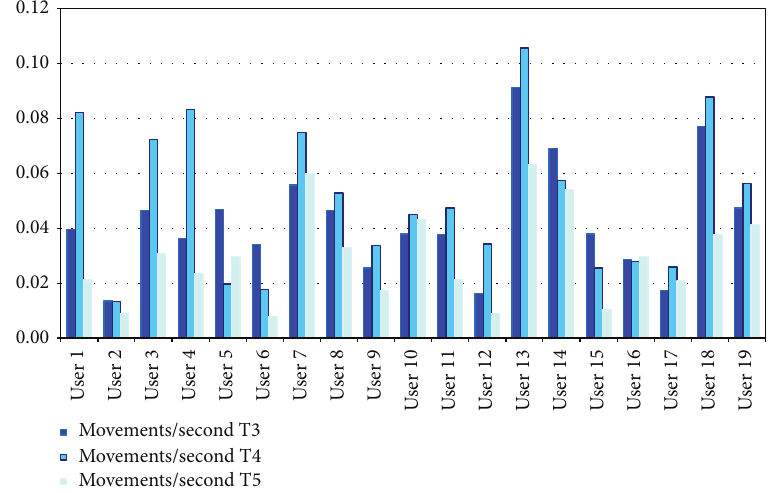
Figure 4: Movement rate showed by each participant (user 𝑖 ) along the three tasks analyzed (T3, T4, and T5).